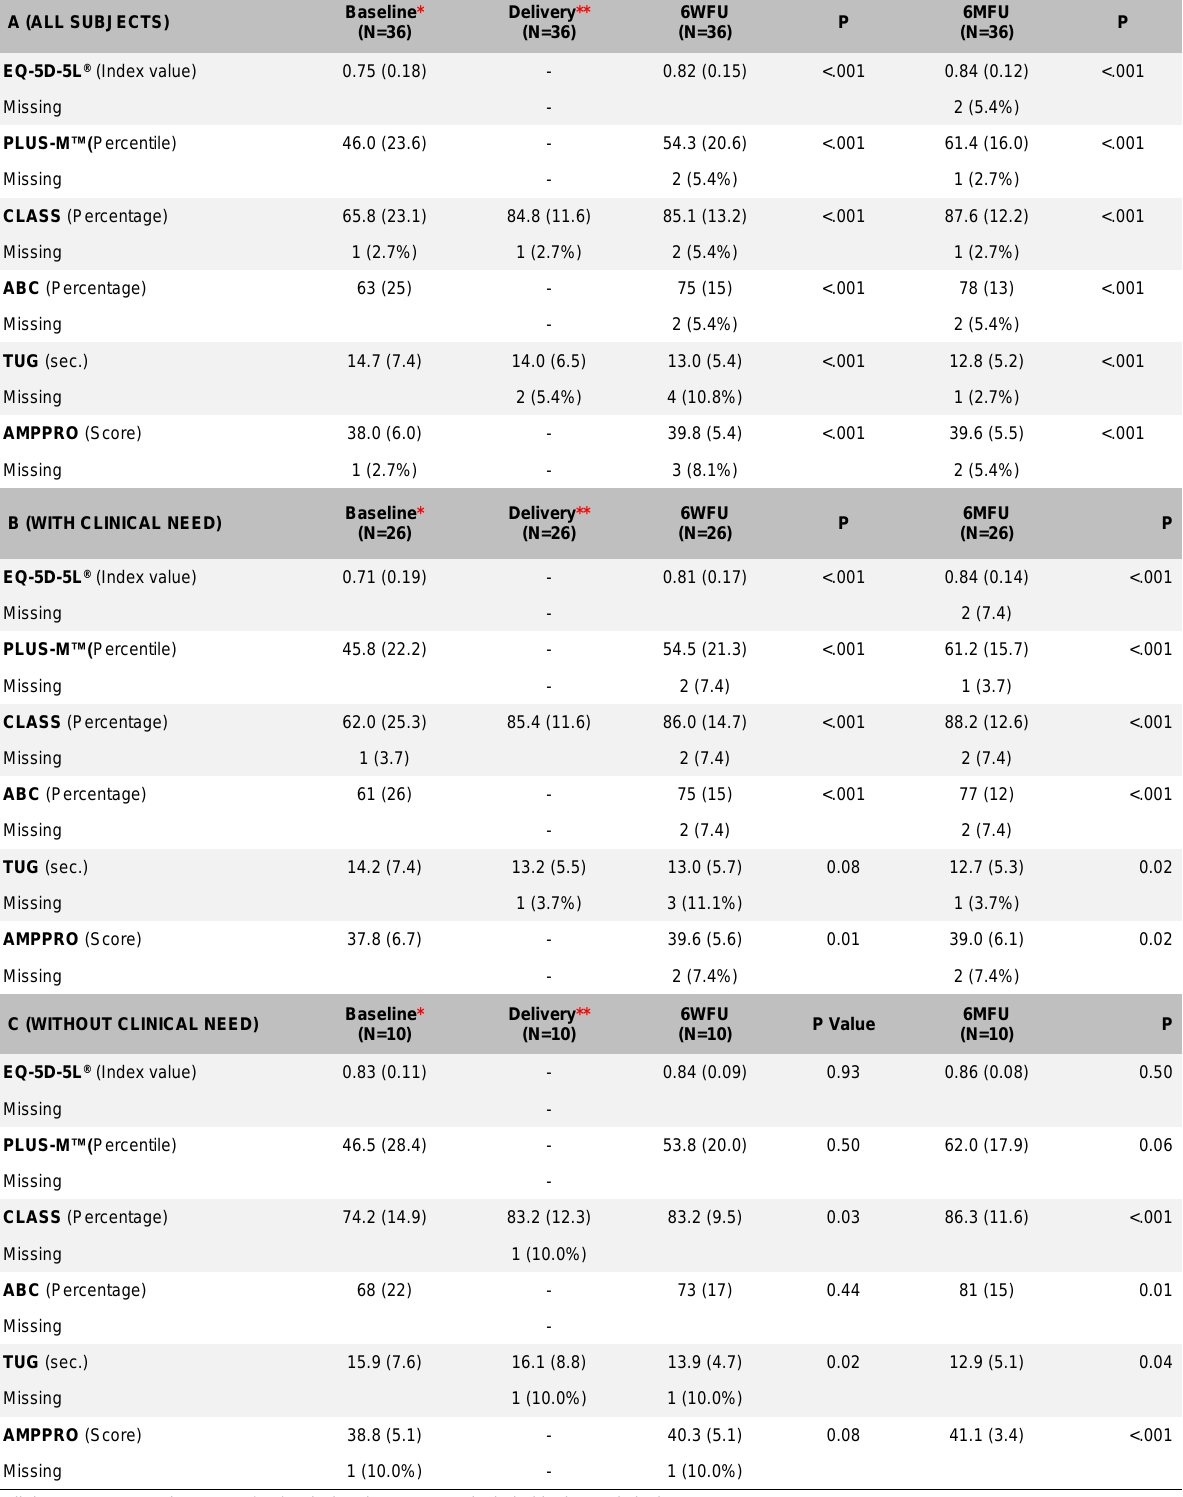
Table 2: Outcome measurements from all subjects (A) of the cohort, with clinical need (B) and without clinical need (C). A (ALL